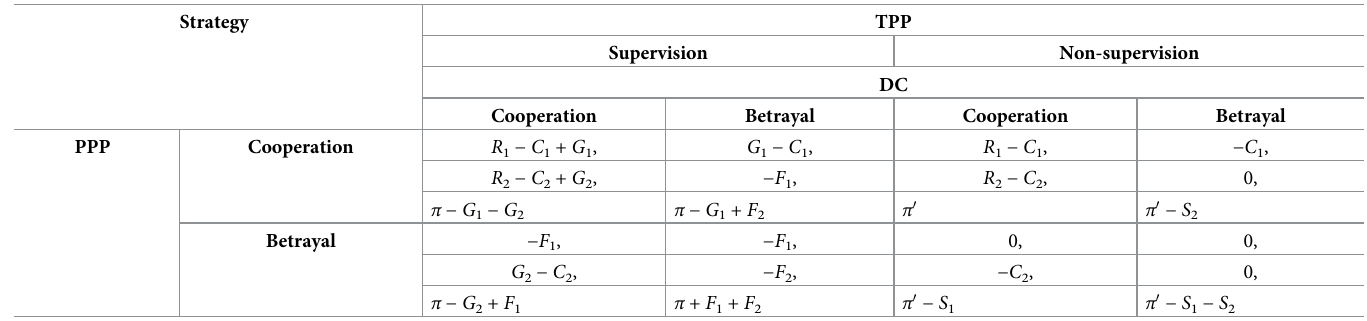
Table 2. Game payment matrix of PPSWPTPP.